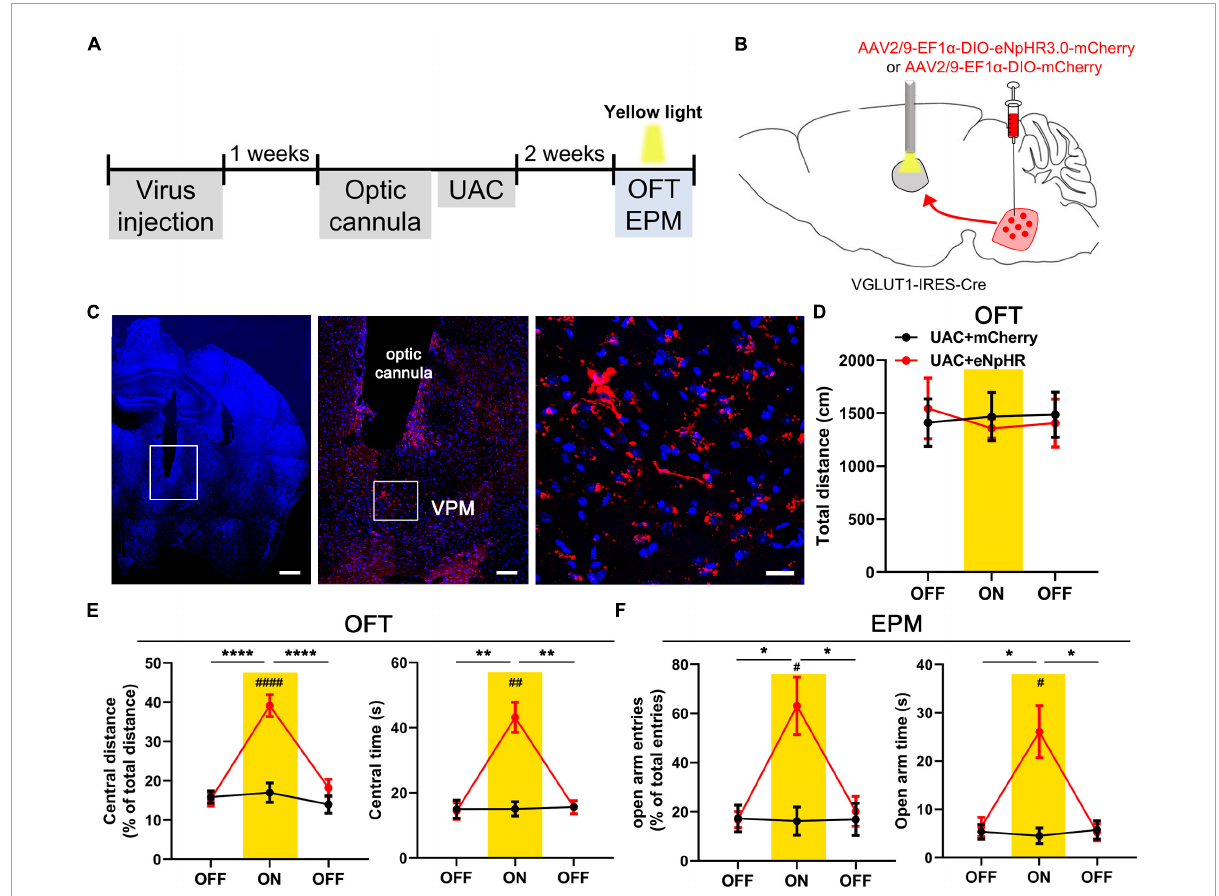
FIGURE7 Optogenetic inhibition of the Vpdm VGLUT1 -VPM pathway reverses anxiety comorbidity in UAC mice. (A) Timeline of the optogenetic inhibition of the Vpdm VGLUT1 -VPM pathway in the behavioral assays. (B) Schematic showing the virus injection and the optic cannula implanted in the Vpdm of VGLUT1-IRES-Cre mice. (C) (Left) Representative coronal brain slice image of the VPM and implantation site of the optical fiber. Scale bar: 50 µ m. (Middle) The enlarged area in the white square on the left side shows the expression of the eNpHR-mCherry terminal and the implantation site of the optical fiber in the VPM. Scale bar: 200 µ m. (Right) The enlarged area in the white square in the middle shows the eNpHR-mCherry terminals in the VPM. Scale bar: 20 µ m. (D) The total distance traveled in the OFT was identical with and without yellow laser stimulation. (E) Optogenetic inhibition of the Vpdm VGLUT1 -VPM pathway increased the percentage of central distance traveled and the time spent in the central area in the OFT. (F) The deactivation of the Vpdm VGLUT1 -VPM pathway increased the percentage of open arm entries and the time spent in the open arms in the EPM. Data are expressed as the mean ± SEM. Tukey’s post hoc was performed between the groups: eNpHR-ON UAC mice ( n = 7) versus eNpHR-OFF UAC mice and eNpHR-ON UAC mice versus mCherry-ON UAC mice ( n = 7). * P < 0.05, ** P < 0.01, **** P <